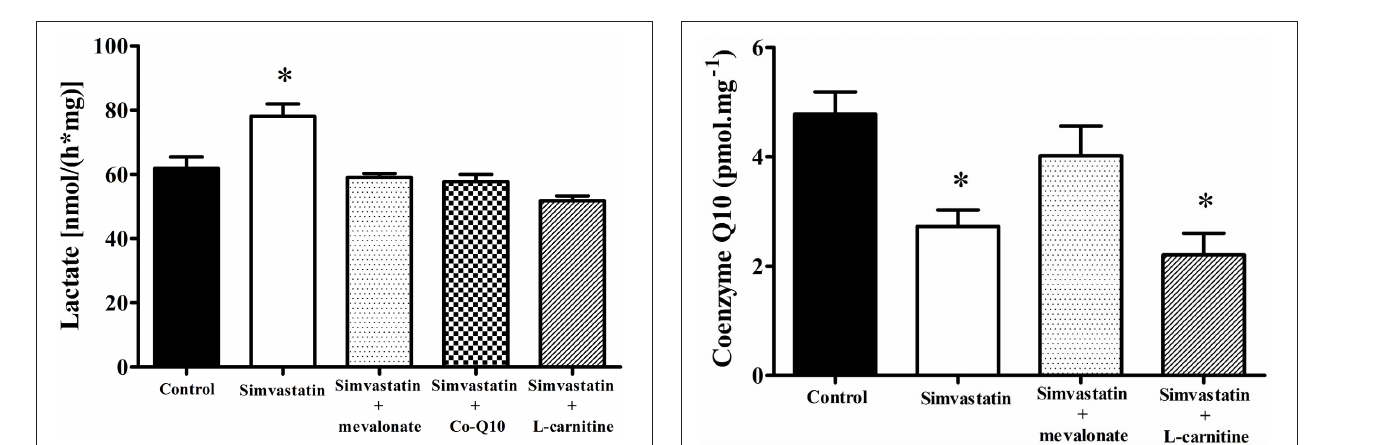
FIGURE 5 | Determination of coenzyme Q10 in skeletal muscle incubated with 1 µ M simvastatin alone or in the presence of mevalonate or L-carnitine. Permeabilized skeletal muscle samples were incubated in MiR05 medium in the presence of 1 μ M simvastatin, or DMSO for 1h in the presence of 100 μ M mevalonate, 10 μ M coenzyme Q10, or 1mM L-carnitine. After tissue homogenization, extraction was performed utilizing perchloric acid and cold methanol. Coenzyme Q10 was measured with a Shimadzu HPLC. ∗ p < 0 . 05 vs. control by one-way analysis of variance. N = at least 9 independent